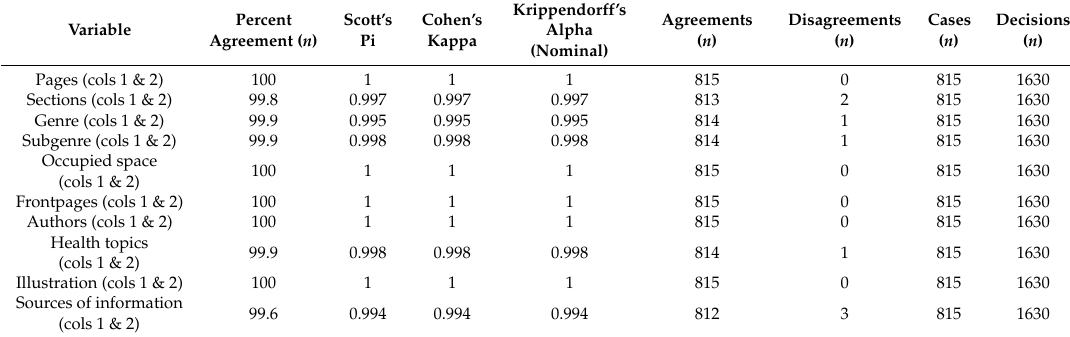
Table 5. Intercoder reliability and percentages.